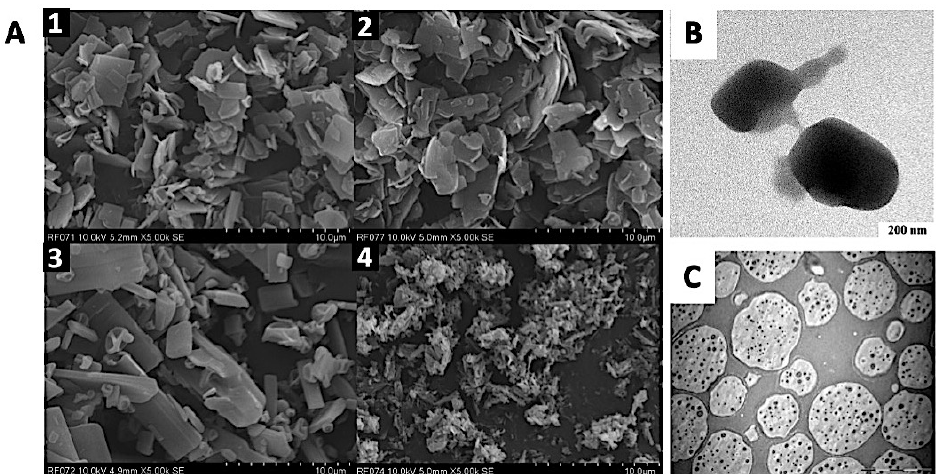
Figure 6. ( A ) Scanning electron microscope (SEM) images of rifampicin crystal from spray-dried samples using (1,2) ethanol, (3) methanol, and (4) water [196]. Reprinted with permission from ref. [196]. Copyright 2020 Elsevier Inc. ( B ) Transmission electron microscope (TEM) image of meropenem particles, scale bar: 200 nm [197]. Reprinted with permission from ref. [197]. Copyright 2020 Elsevier Inc. ( C ) SEM image of cross-sections of Poly(lactic-co-glycolic acid) (PLGA) microspheres